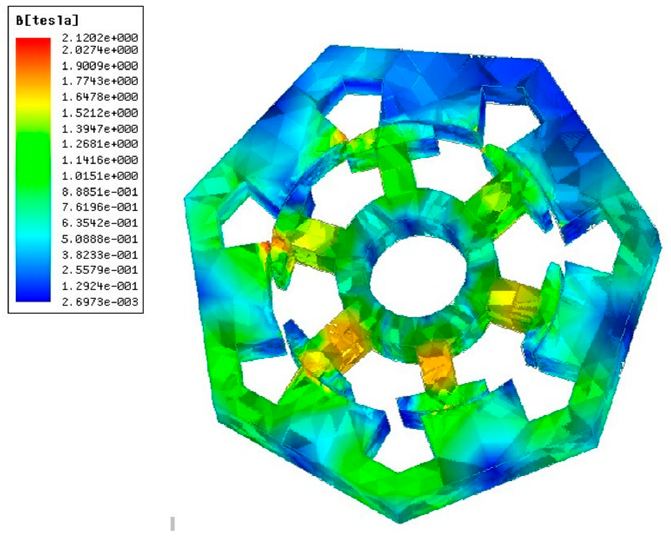
Figure 7. Magnetic induction distribution of the stator and the rotor.